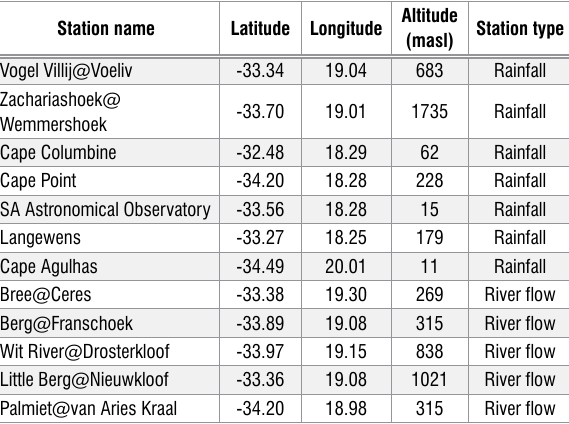
Map showing the Western Cape rainfall stations from which data were sourced in this